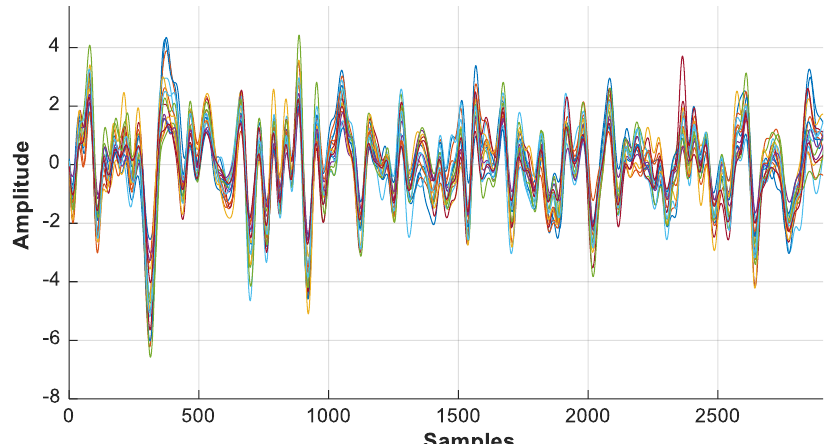
Figure 7. List of good/bad channels to remove bad channels from the analysis and signal classifica- tion.